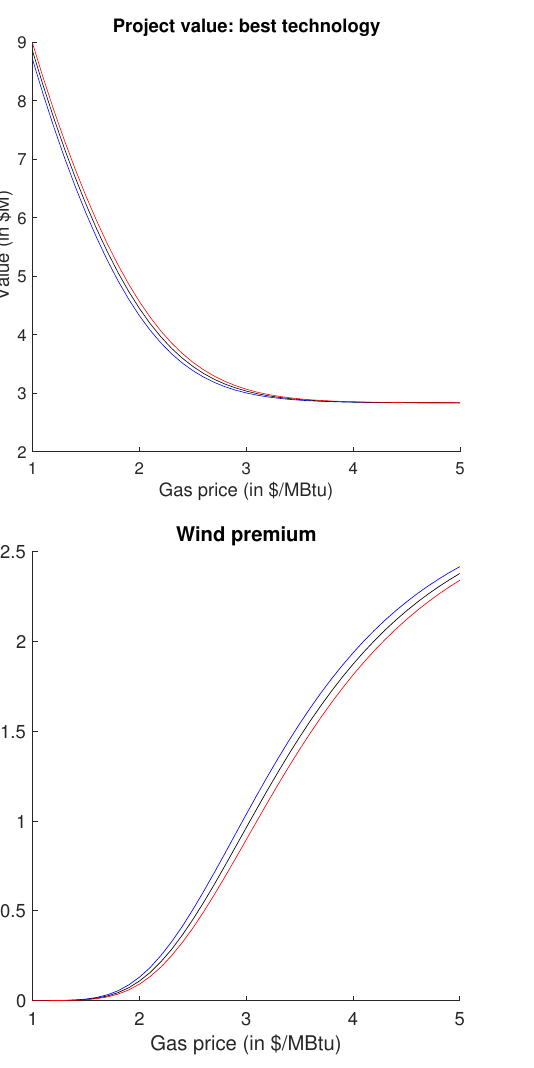
Figure 11. This figure displays the effects of parameter B on the project value (upper panels) and wind premium (lower panels) at t = 0 in case of low sensitivity of the gas price ( C = 0, left panels) and of high sensitivity ( C = 2.5, right panels). The value of X 0 is 50$/MWh. The values of B are: B = 0 (blue), B = 4 (black), B = 8 (red). Other parameter values are given in Table 1; the investment horizon is T = 1